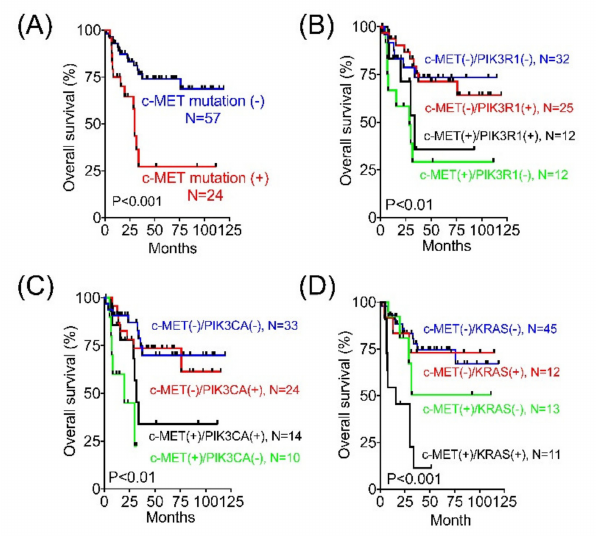
Figure 1. Impact of MET mutation and concurrent genetic mutations on the clinical outcome of advanced endometrial cancer. ( A ) Kaplan–Meier curves for overall survival (OS) in patients with and without MET mutation compared using the log-rank test. ( B – D ) Kaplan–Meier curves for OS were analyzed between the MET wild-type and MET mutant patients with or without concurrent PIK3R1 ( B ), PIK3CA mutation ( C ), and KRAS ( D